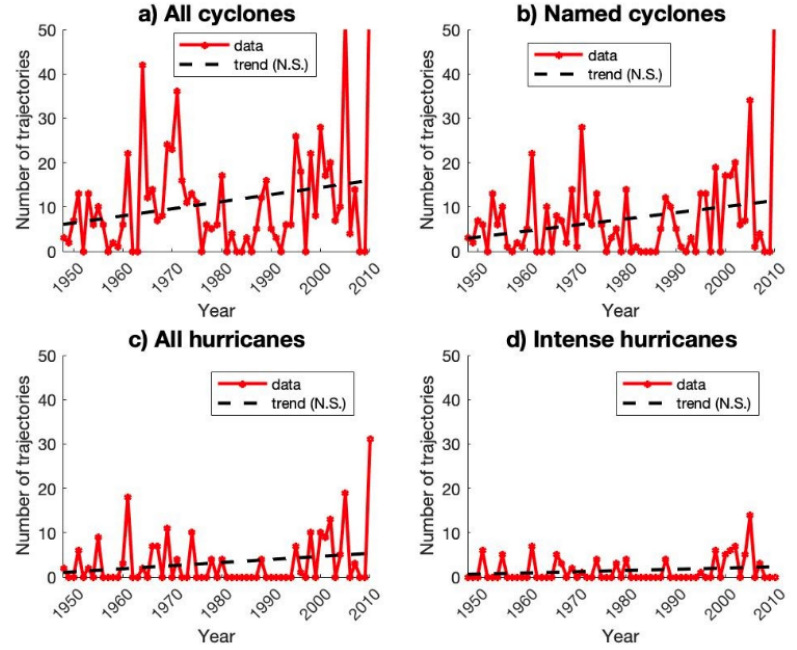
Figure 3. Annual number of tropical cyclones in the region bounded by 14.5 ◦ N to 23 ◦ N and 84 ◦ W to 90 ◦ W. Named cyclones refer to tropical storms and hurricanes category 1 to 5. All hurricanes refer to hurricanes categories 1 to 5. Intense hurricanes are those reaching category 3 to 5. Each subfigure correspond to the number of trajectories for all cyclones The red lines are the number of trajectories en the selected region and the dashed black line is the trend. Non-significant trends at the 95% confidence level are indicated with N.S.. Data 1948–2010. ( a ) All cyclones, ( b ) named cyclones, ( c ) all hurricanes, ( d ) intense